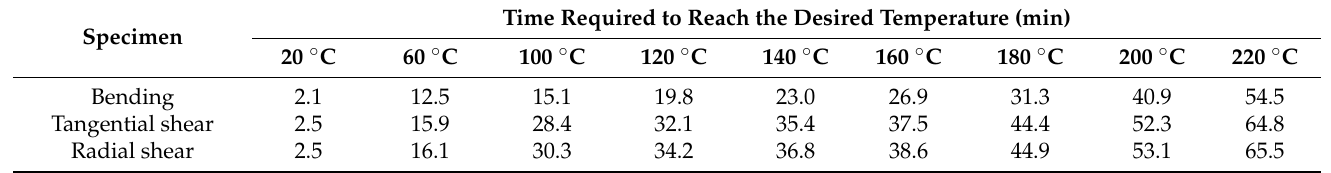
Table 1. Time required for heating the specimen to reach the desired